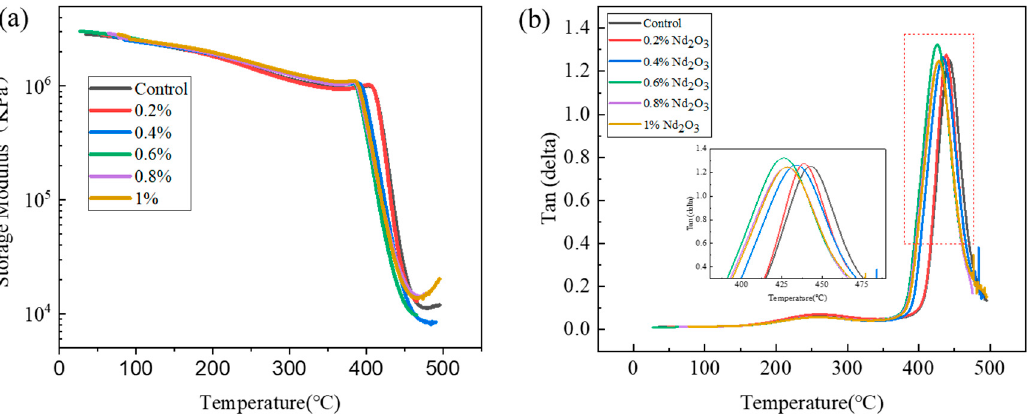
Figure 7. The DMA curve of the polyimide with different contents of Nd2O3: ( a ) storage modulus and ( b ) tan δ .